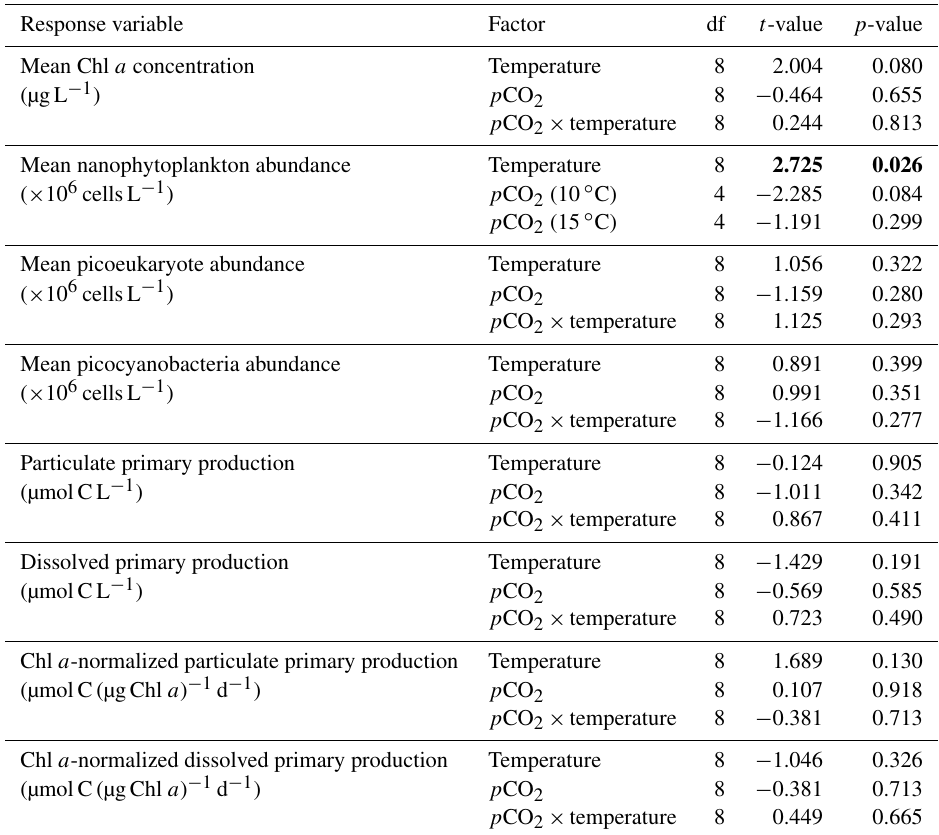
Table 2. Results of the generalized least squares models (gls) tests for the effects of temperature. p CO 2 and their interaction during Phase I (day 0 to the day of maximum Chl a concentration). Separate analyses with p CO 2 as a continuous factor were performed when tempera- ture had a significant effect. Chl a concentration, nanophytoplankton abundance, picoeukaryote abundance, picocyanobacteria abundance, particulate and dissolved primary production, and Chl a -normalized particulate and dissolved primary production. Significant results are in